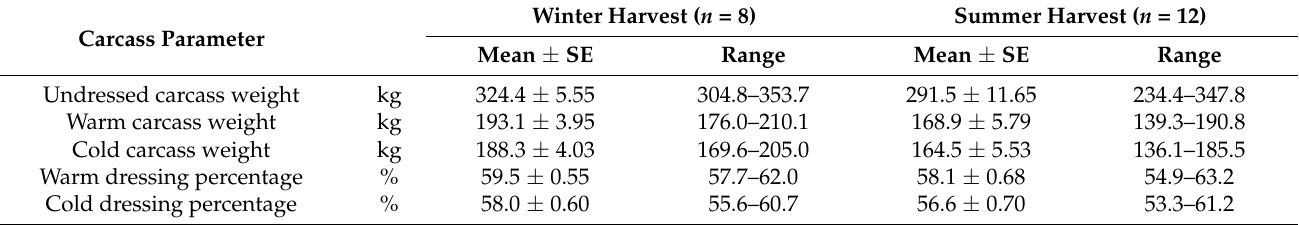
Table 1. Mean ( ± standard error) and the range of carcass yields from eight Plains zebra stallions harvested in the winter season and 12 Plains zebra stallions harvested in the summer